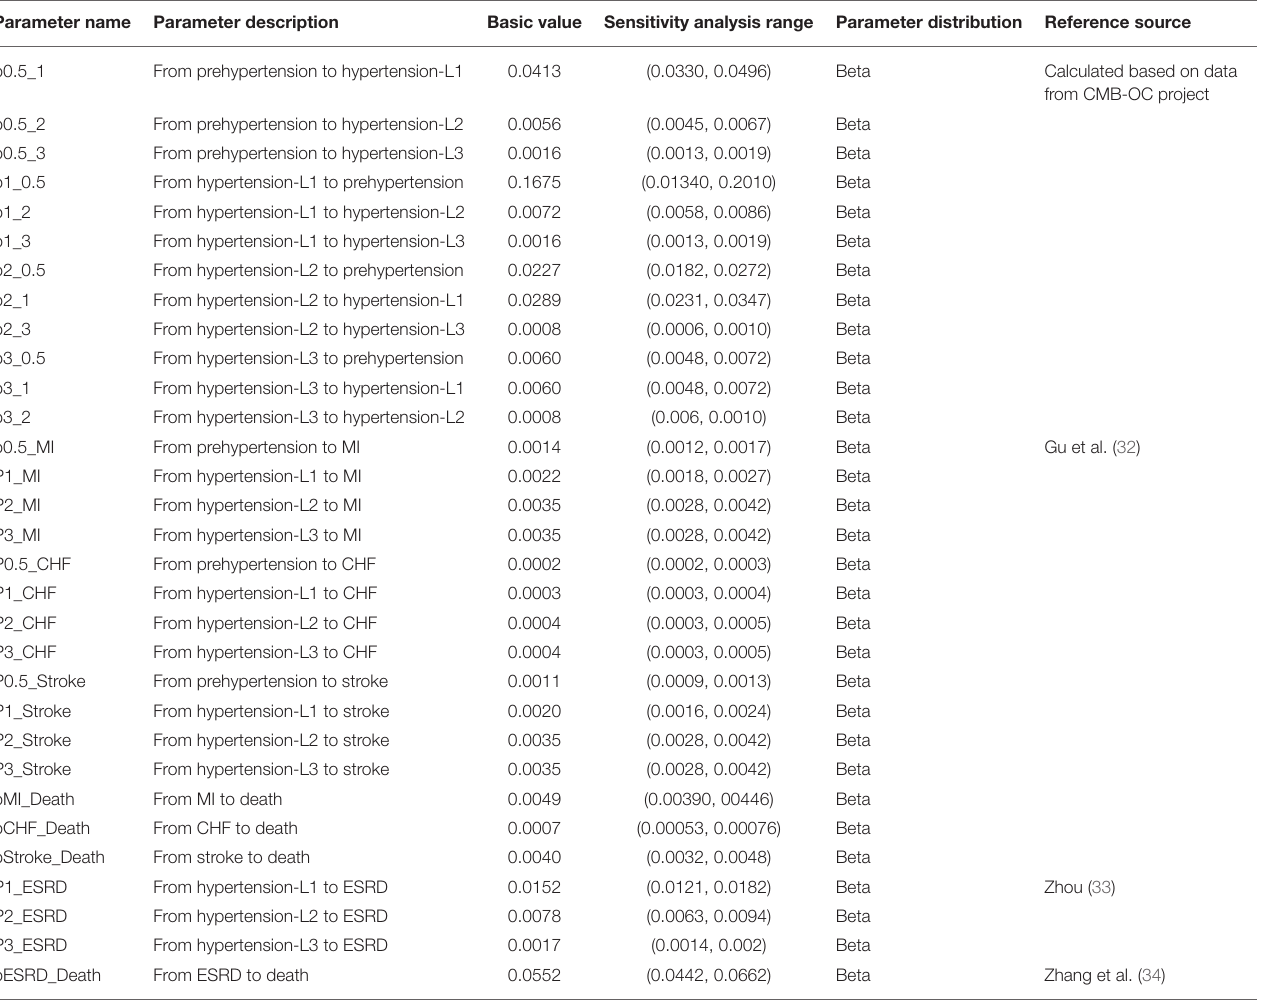
TABLE 4 | Transition probabilities among different health states, sensitivity analysis range, parameter distribution, and sources. Parameter name Parameter